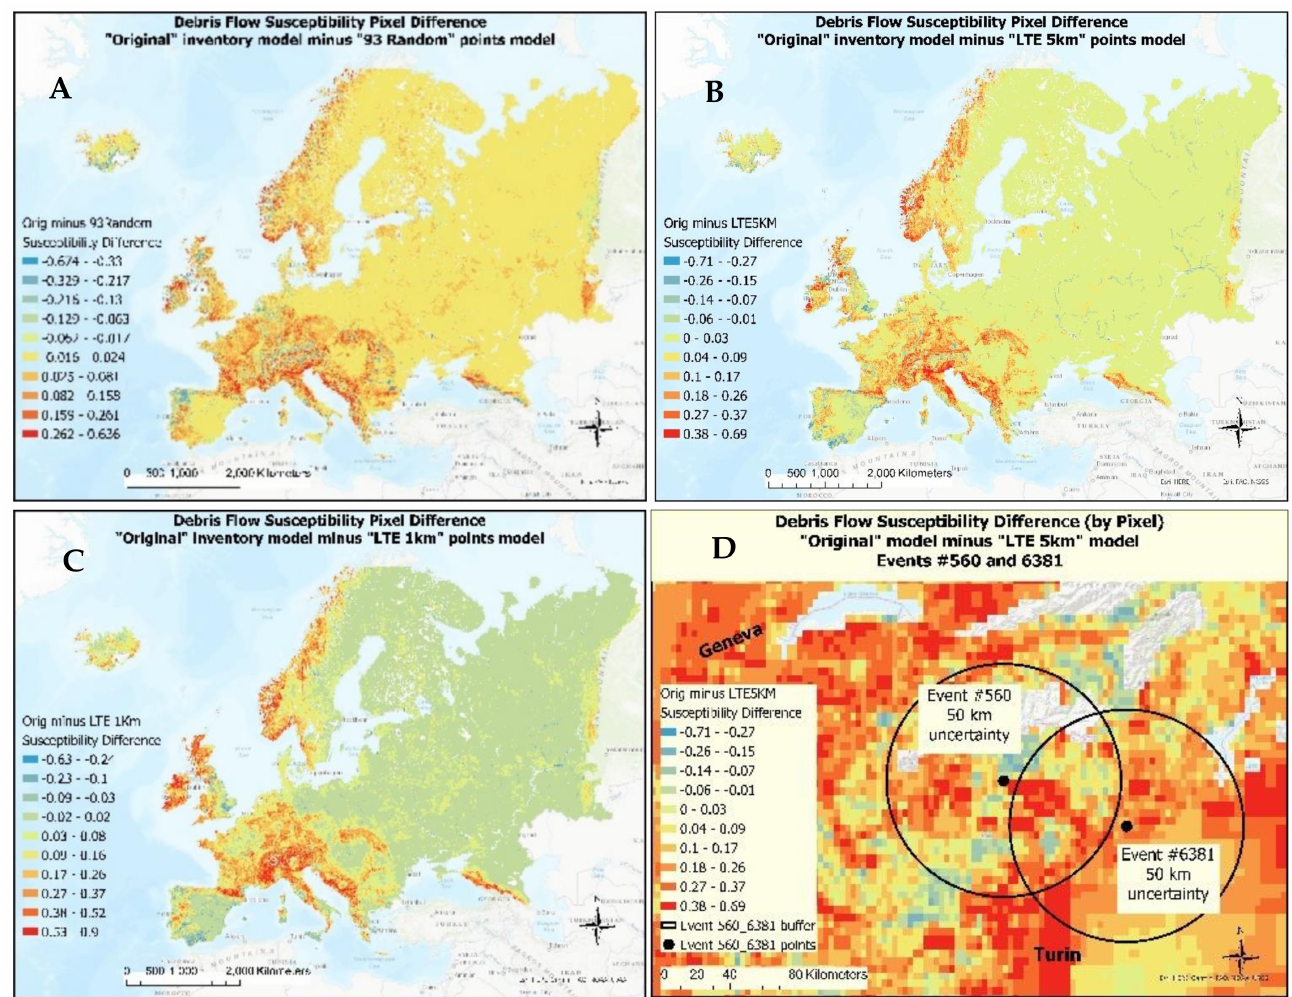
Figure 8. Model susceptibility differences. ( A ). Pixel difference between “Original” and “93 Random” models. ( B ). Pixel difference between “Original” and “LTE 5km” models. ( C ). Pixel difference between “Original” and “LTE 1km” models. Warmer colors represent areas of higher susceptibility values in “Original” model. ( D ). Map 9B zoomed into area around the Italian Alps for visual enhancement of susceptibility disparities. Base maps are from ArcGIS ® , the intellectual property of Esri, used herein under license. Copyright©